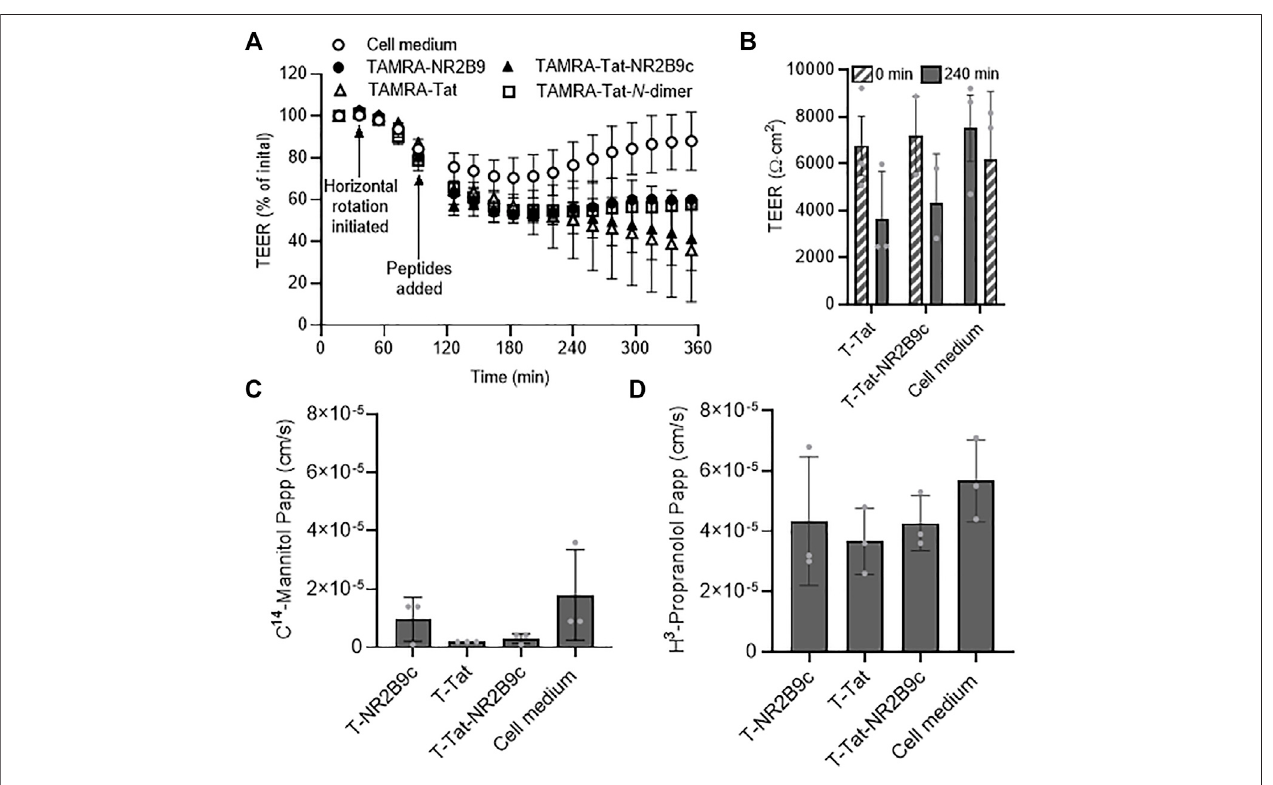
FIGURE 4 | Kinetics of barrier integrity and transport of the small transcellular marker H 3 -propranolol or the small paracellular marker C 14 -mannitol during peptide incubation. (A) Real-time transendothelial electrical resistance (TEER) measurements across BIONi010-C monolayers during incubation with 50 μ M T-NR2B9c, T-Tat, T-Tat-NR2B9c, or T-Tat- N -dimer for 6 h at 37 ° C using a CellZScope device. Mean ± SD ( N = 3). (B) TEER measurements across BIONi010-C monolayers before and after incubation with50 μ M T-Tat or T-Tat-NR2B9cfor4 h at37 ° Cusing chamber electrodes.Mean ±SD( N =3, n =3). (C) C 14 -mannitol permeability and (D) H 3 - propranololpermeability acrossBIONi010-C monolayers after 4-hincubation alone incellmedia orwith50 μ MT-NR2B9c, T-Tat, orT-Tat-NR2B9c at 37 ° C.Mean ±SD ( N = 3, n = 3).